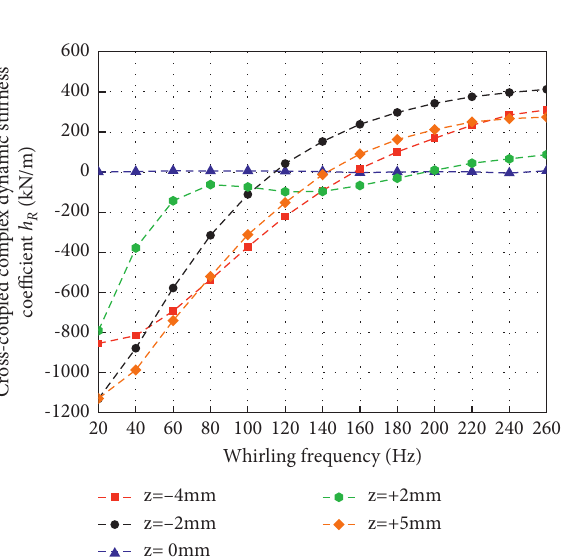
Figure 8: Direct complex dynamic stiffness coefficient vs. whirling frequency.